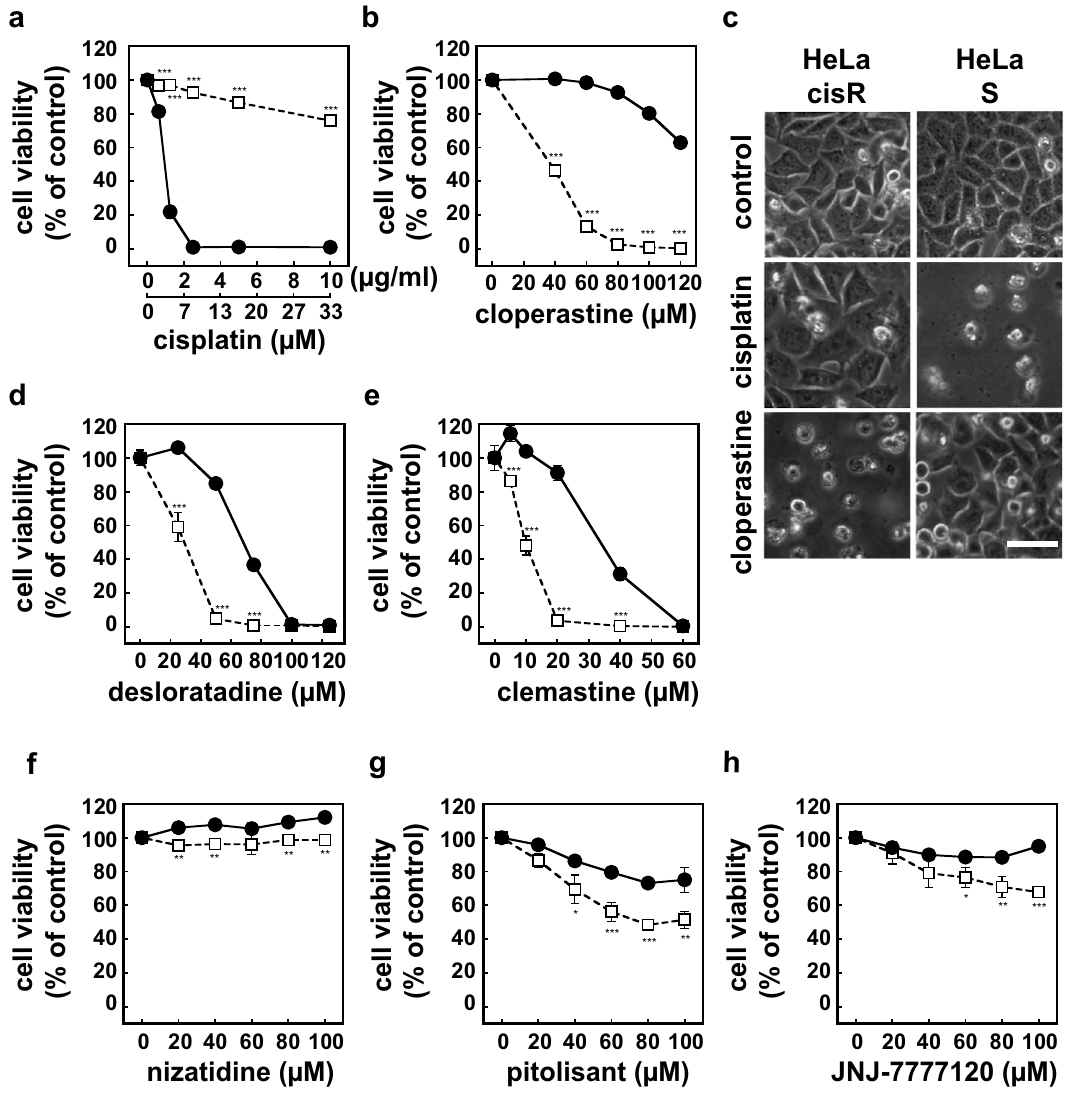
Figure 1. Cloperastine and other H1 receptor antagonists selectively kill HeLa cisR cells. ( a , b , d – h ) HeLa cisR cells (open squares) and HeLa S cells (filled circles) were cultured for 3 days with or without the indicated concentrations of cisplatin ( a ), the histamine H1 receptor antagonists cloperastine ( b ), desloratadine ( d ), or clemastine ( e ), or the H2 receptor antagonist nizatidine ( f ), H3 receptor antagonist pitolisant ( g ), or H4 receptor antagonist JNJ-7777120 ( h ). Cell viability during the final 5 h of the culture period was evaluated using WST-8 colorimetric assays. Open squares, HeLa cisR cells; filled circles, HeLa S cells. The results are presented as means ± S.D. of sextuplicate (n = 6) ( a , b , d , e ) or quadruplicate (n = 4) ( f – h ) samples. Four separate experiments yielded essentially the same results. Note that only H1 receptor antagonists resulted in 0% cell viability. Also note that error bars are not visible in many places due to their small size. The significance of the difference between the results from HeLa S and HeLa cisR cells at the same concentration of the indicated compound was determined with ANOVA (***p < 0.001; **p < 0.01; *p < 0.05). ( c ) HeLa cisR and HeLa S cells cultured for 3 days with 10 µg/ml cisplatin or 100 µM cloperastine were photographed under a phase contrast microscope. Bar, 50